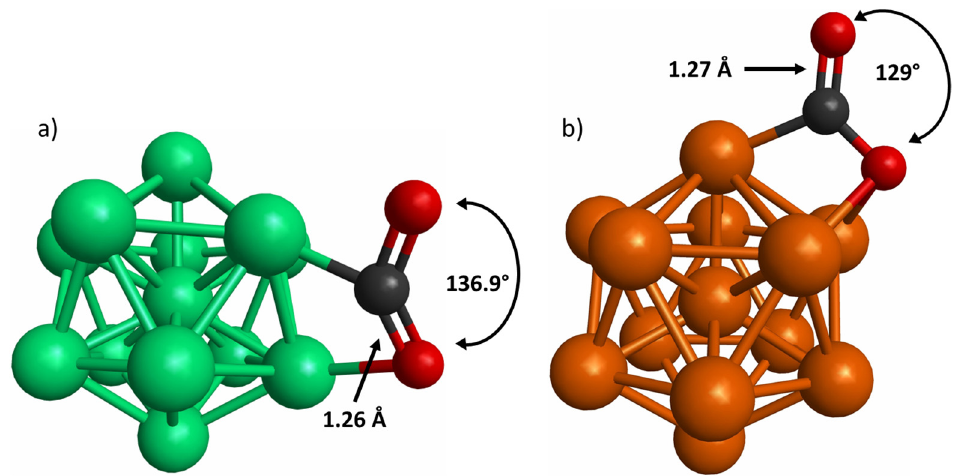
Figure 5. CO 2 adsorbed on ( a ) Co 13 and ( b ) Cu 13 nanoclusters. The average bond length (Å) and angle bending (°) of CO 2 molecule is depicted. Green, orange, black, and red spheres represent Co, Cu, C, and O atoms, respectively.